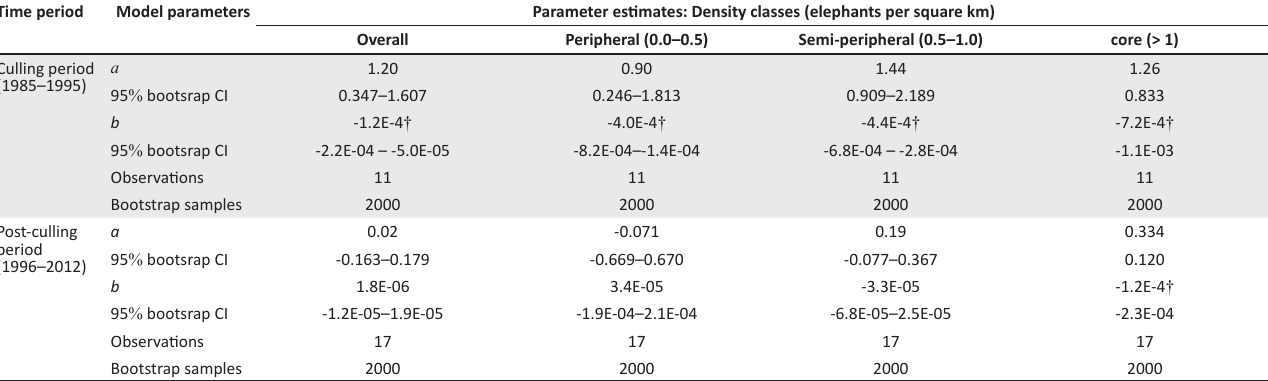
TABLE 2-A1: Parameter estimates of stochastic Ricker model fitted to the time series of elephant population size, as part of test for negative density-dependent growth.